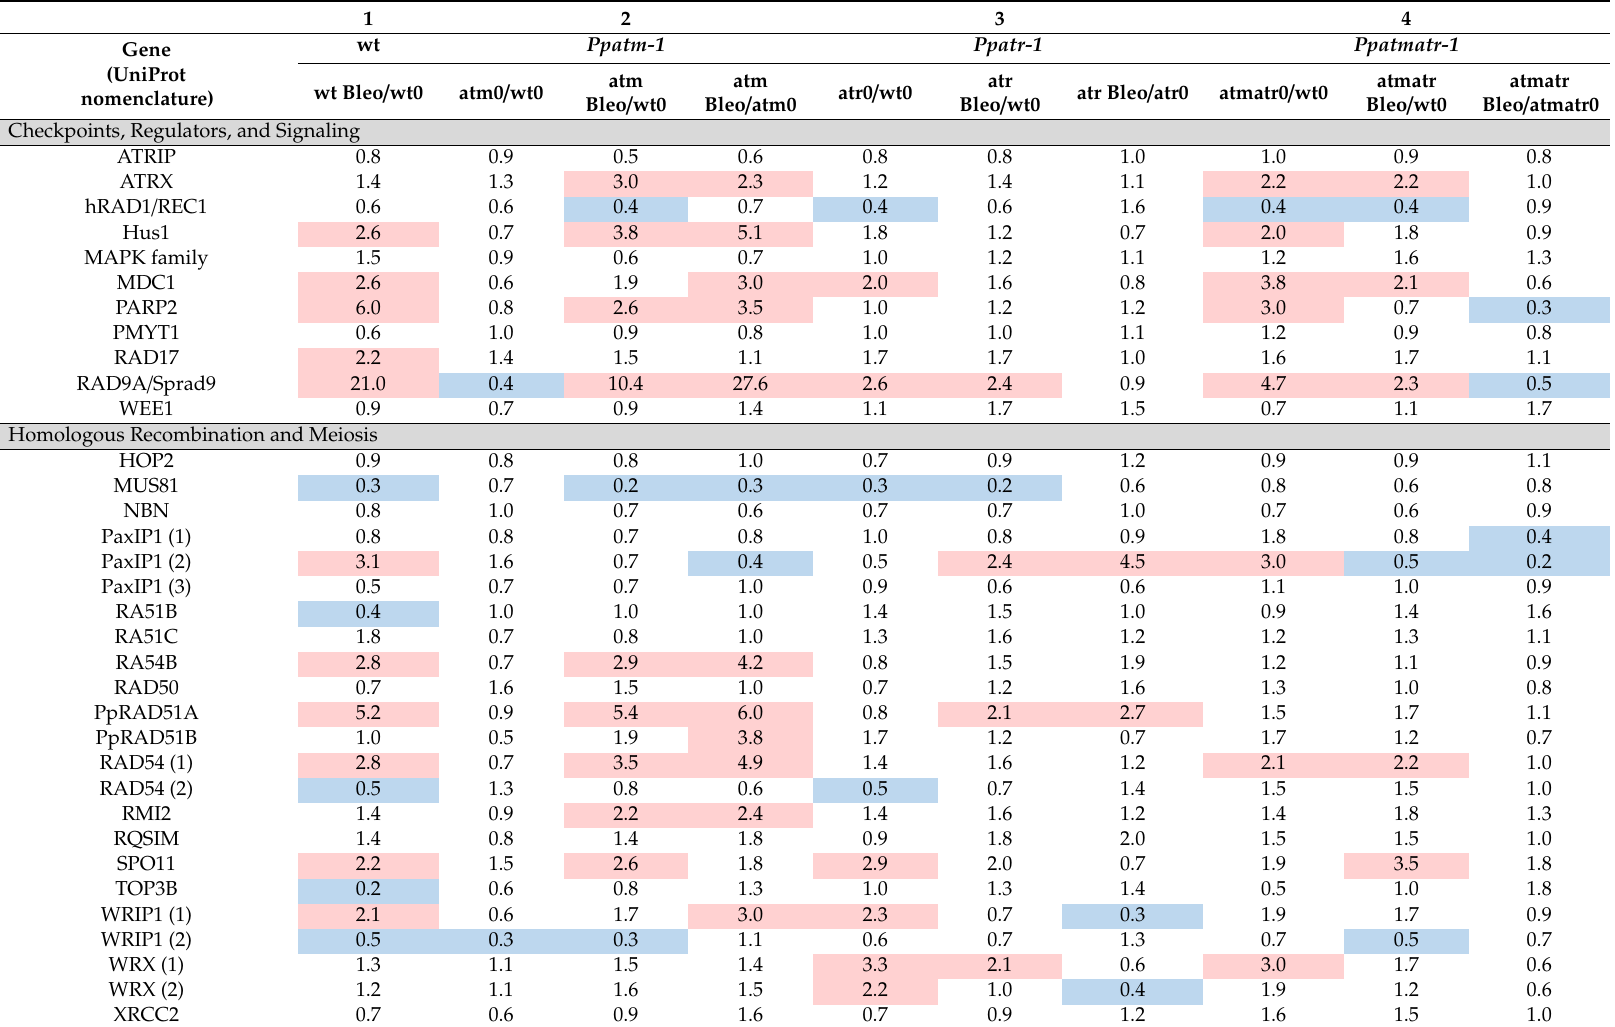
Table 1. DNA damage repair gene-specific di ff erential expression